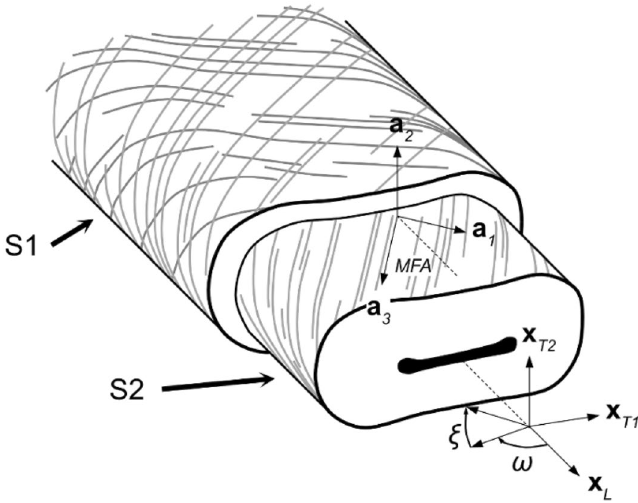
Figure 1. Schematic illustration of a pulp fiber. Most of the fiber volume is in the S2 layer, while the S1 layer forms an outer shell. During the papermaking process, the S1 layer is damaged, partially exposing the underlying S2 layer. The fiber is characterized by the base { x T 1 , x T 2 , x L } , while the material base is represented by { a 1 , a 2 , a 3 } . Relative to the fiber axis, the microfibrils are aligned at an angle, typically between 0° and 40° 1 , illustrated here by the angle between the axis x L and a 3 . The S2 layer is transversely isotropic, with the axis of symmetry (the strong direction) oriented along a 3 . The S1 layer has a less well-defined fibril orientation, which is, here, represented by two different orientations of the fibrils in the plane of the fiber